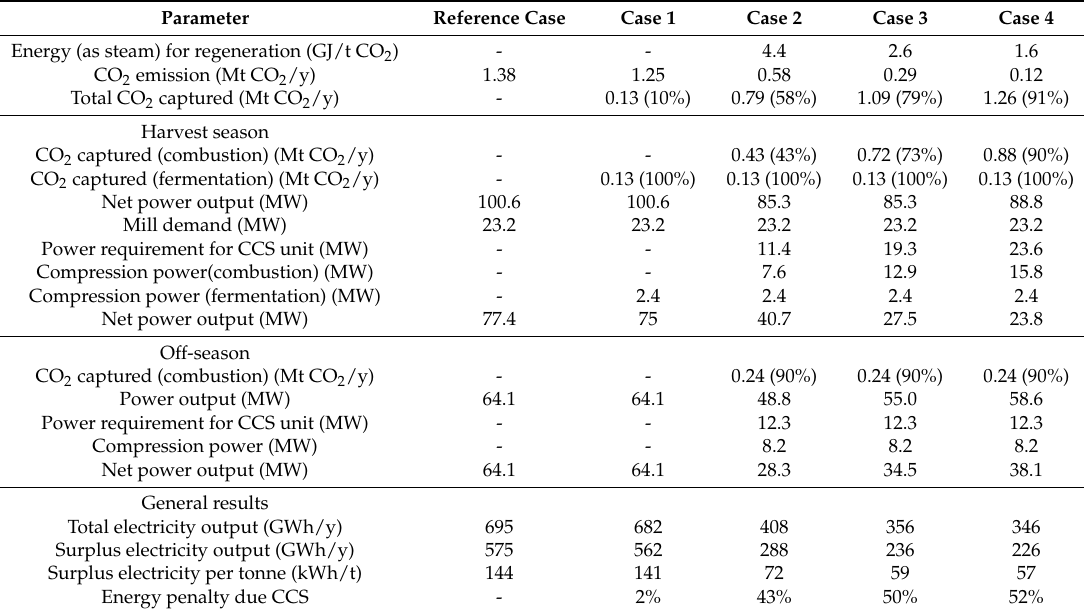
Figure 1. BECCS process flow diagram (harvest season). Table 3. Performance results for the BECCS